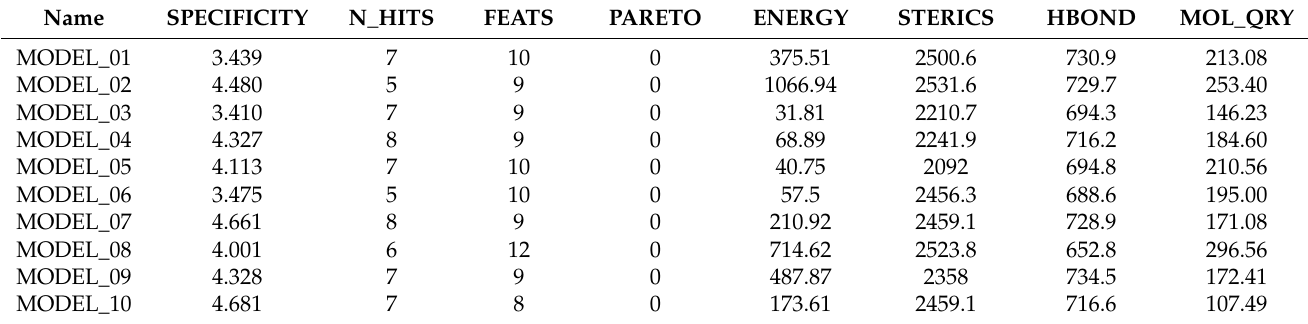
Table 3. Statistical results of the ten top-scoring pharmacophore